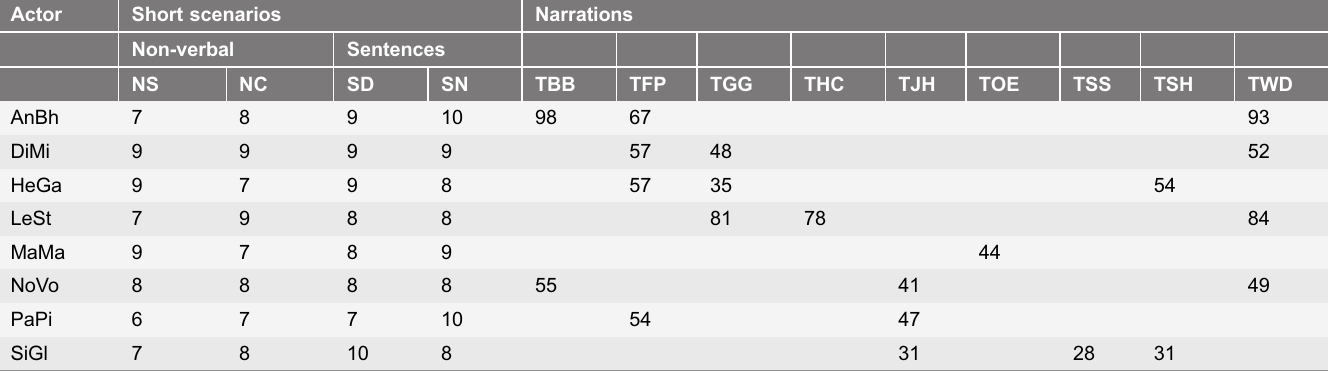
Table 5. Frequencies in the final set of motion sequences across actors and acting tasks. Actor Short